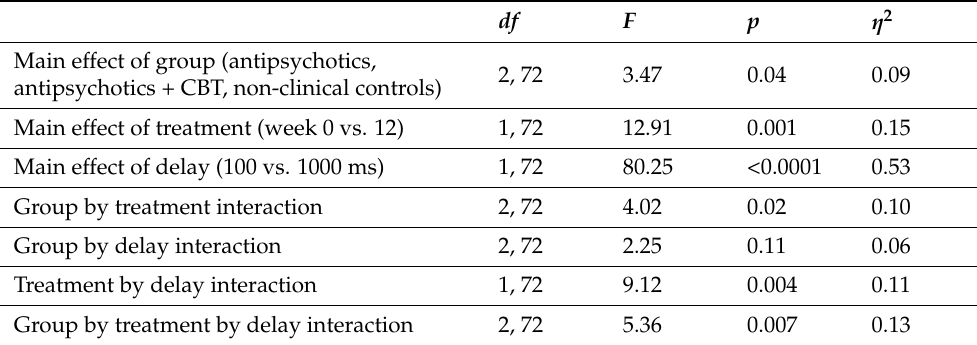
Table 2. Summary of the results from the ANOVA conducted on postdiction scores (probability of predicting red